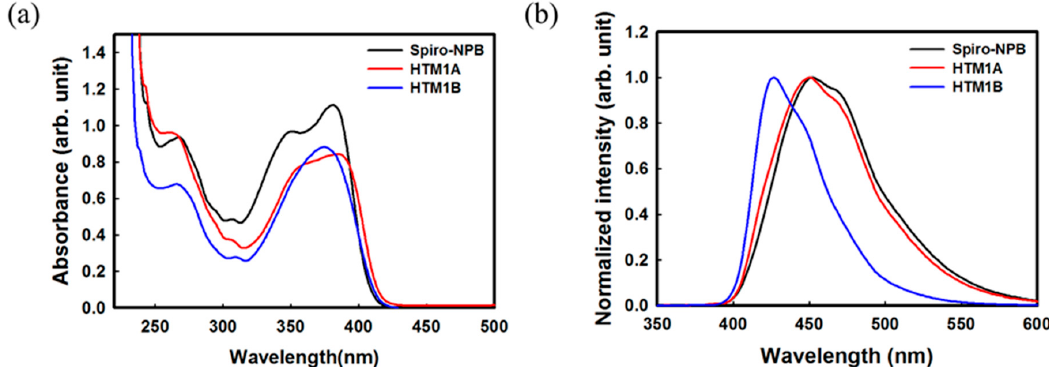
Figure 1. UV-visible absorption ( a ) and PL spectra ( b ) of HTMs 1A , 1B and Spiro-NPB.